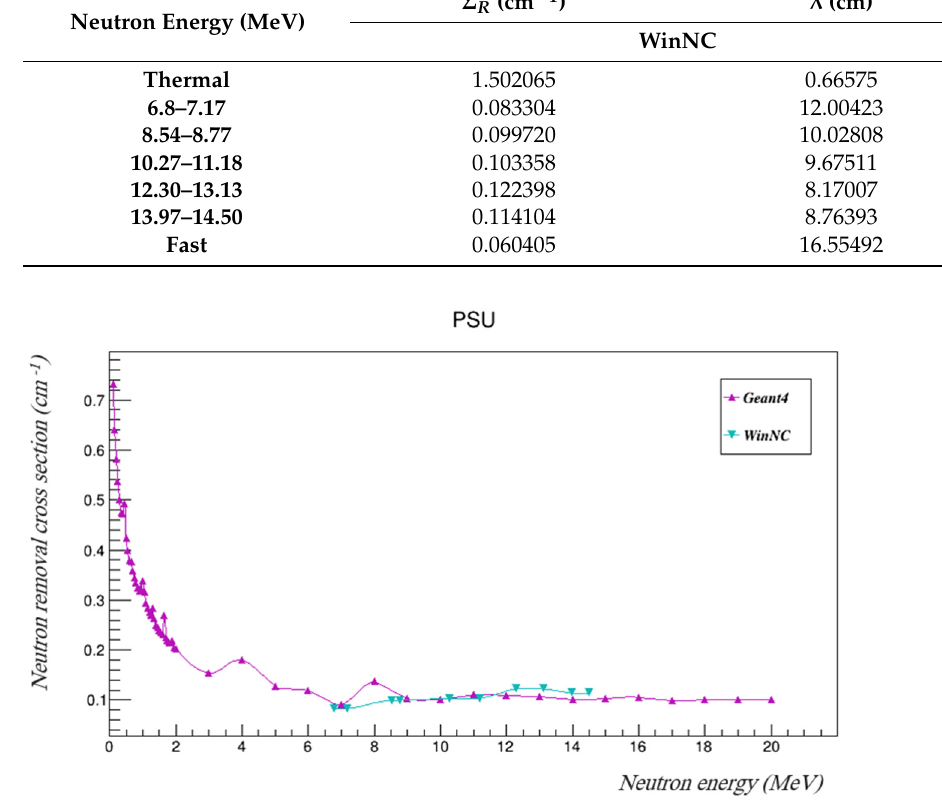
Figure 8. The neutron mean free paths of PSU at the investigated gamma energies using both Geant4 and WinNC. The results of WinNC are comparable to those of Geant4 at the available energies, as can be seen in Figures 7 and 8.